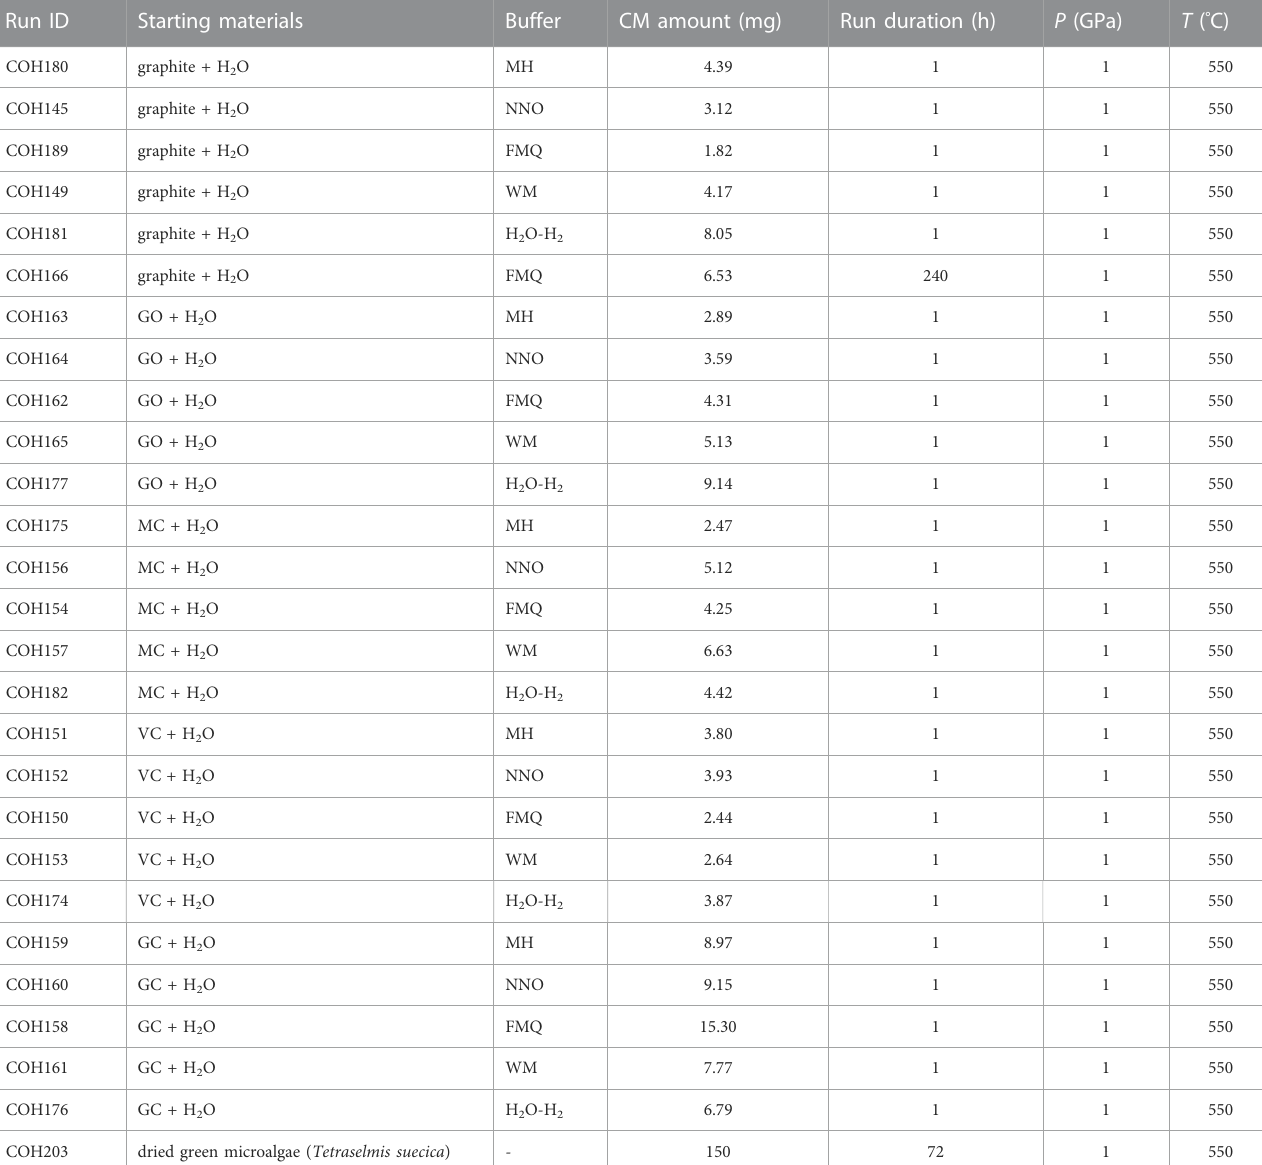
TABLE2Runtableoftheexperiments.Thestartingmaterialsareabbreviatedasfollows:GO,graphiteoxide;MC,mesoporouscarbon;VC,Vulcan ® carbon;GC,glass-like carbon. Run